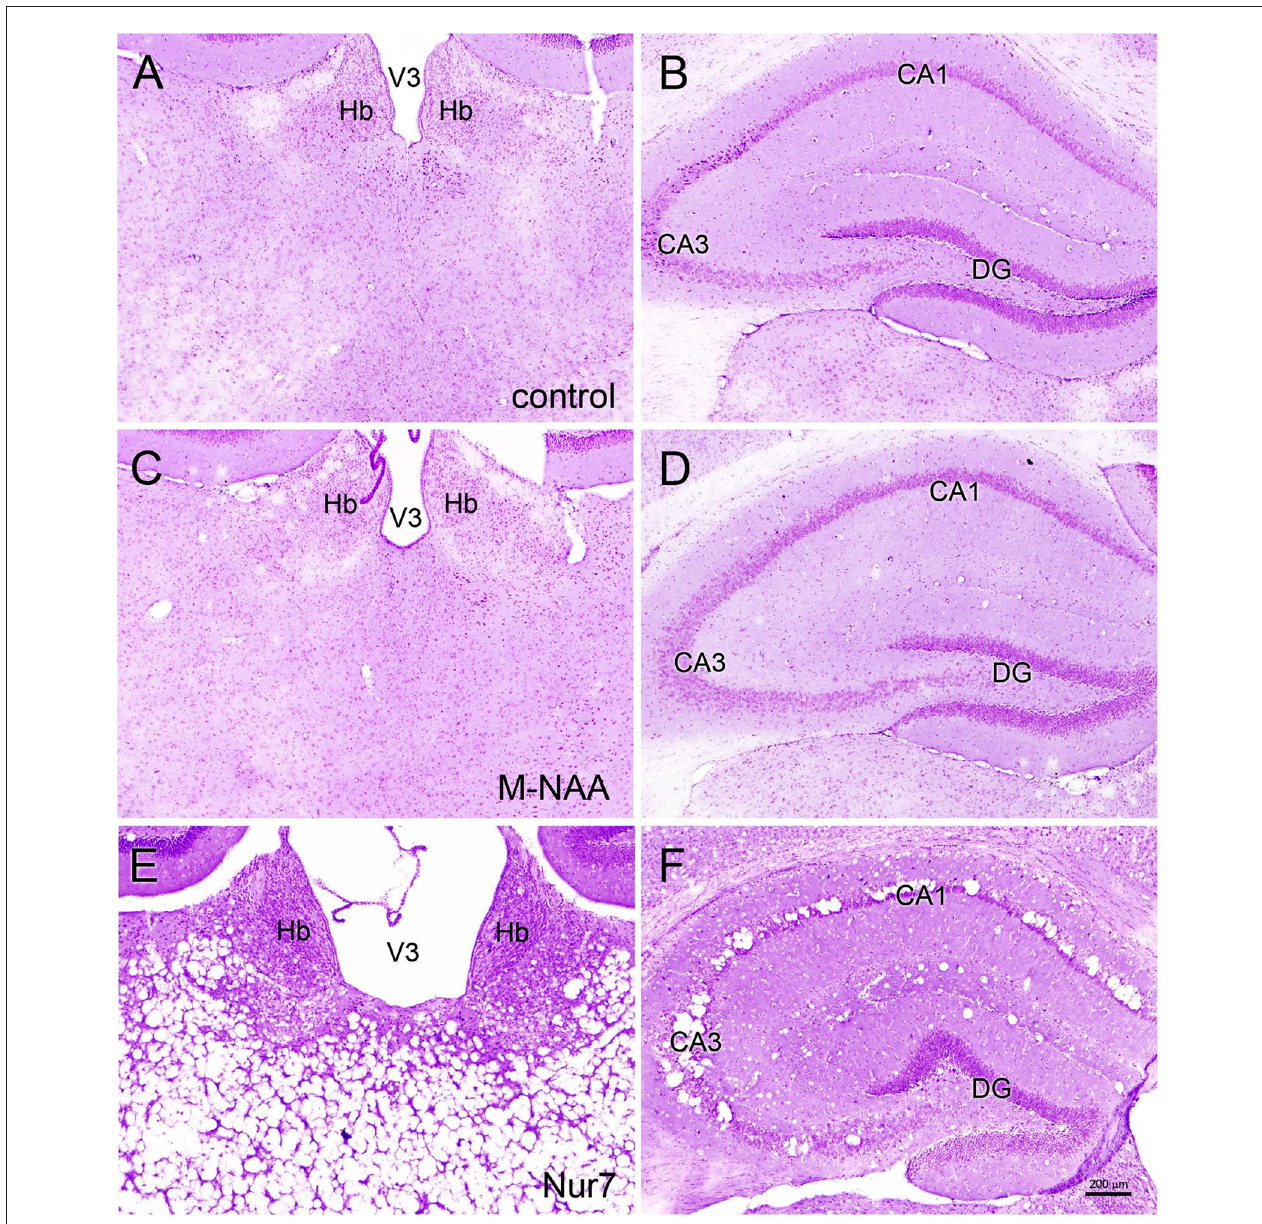
FIGURE 4 | Histopathology. Representative hematoxylin staining in the dorsal thalamus and hippocampus of control (A,B) , M-NAA treated (C,D) and Nur7 mice (E,F) . No vacuoles or other histopathological changes were observed after 30 day treatment with either M-NAA (5 g/kg twice per day) or methanol (0.84 mg/kg twice per day; data not shown). Extensive vacuolization was observed in many brain regions of Nur7 mice, including the thalamus and hippocampus (E,F) . Abbreviations: CA1 and CA3, CA1 and CA3 pyramidal cell layers of hippocampus; DG, dentate gyrus of hippocampus; Hb, habenula; V3, third ventricle. Micron bar = 200 µ